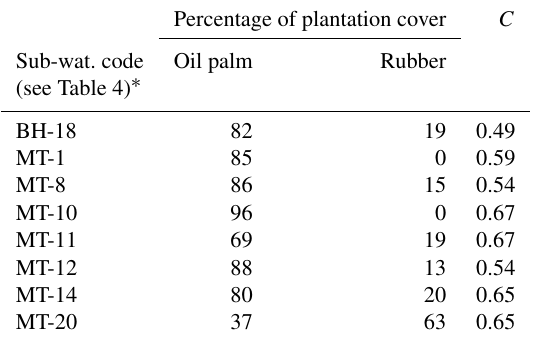
Table 6. Simulated C values for the sub-watersheds used in the SWAT simulation (Table 4) that had similar percentages of planta- tion cover to the two small watersheds used in the field experiments. Percentage of plantation cover Sub-wat.